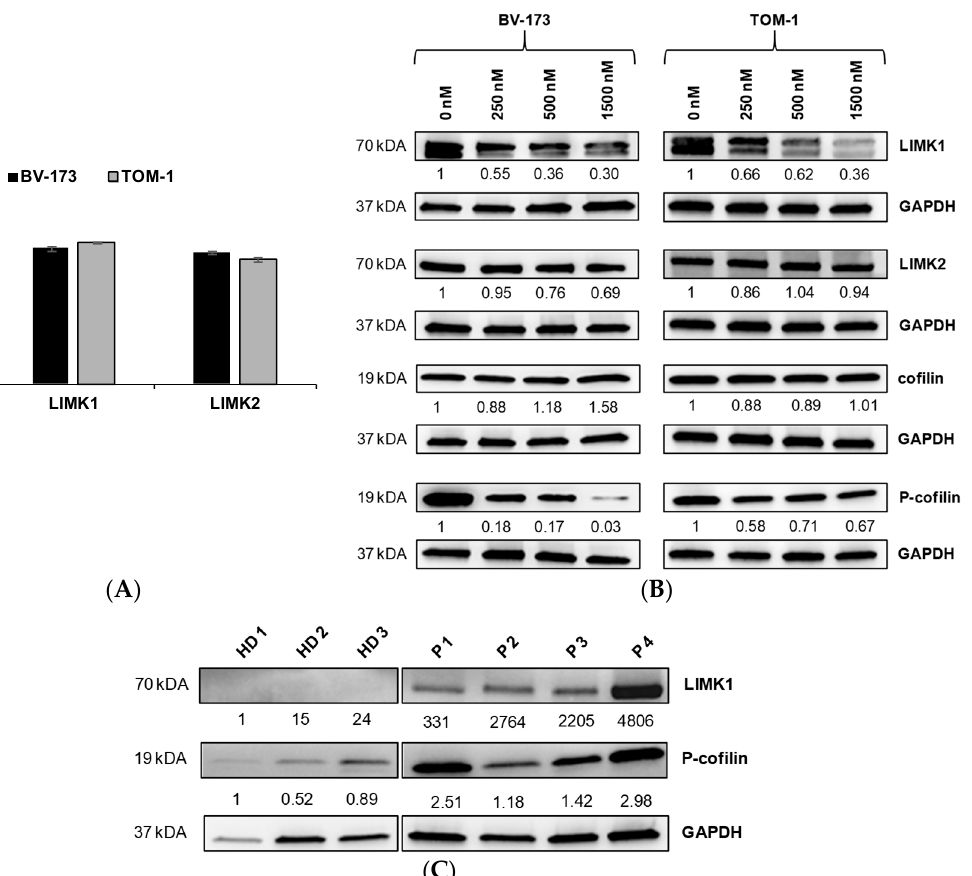
Figure 2. LIMK1 and LIMK2 basal expression and in vitro effect of LIMKi on LIMK1, LIMK2, cofilin, and phospho-cofilin protein expression in BCR::ABL1 + ALL cell lines and patient cells. LIMK1 and LIMK2 basal gene expression in BV-173 and TOM-1 cell lines were determined by RT-qPCR. Results are shown as mean ± SEM from triplicates ( n = 3) ( A ). Western blot showing protein changes of LIMK1, LIMK2, cofilin, and phospho-cofilin in BV-173 and TOM-1 cell lines after 72 h exposure to increasing CEL_Amide doses (250–1500 nM). GAPDH was used as a loading control. One representative experiment out of three is shown ( B ). Western blot showing basal LIMK1 and phospho-cofilin expression in healthy donors ( n = 3) and BCR::ABL+ ALL patients ( n = 4) ex vivo ( C ). Densitometry for LIMK1, LIMK2, cofilin, and phospho-cofilin proteins were reported as a ratio with GAPDH.